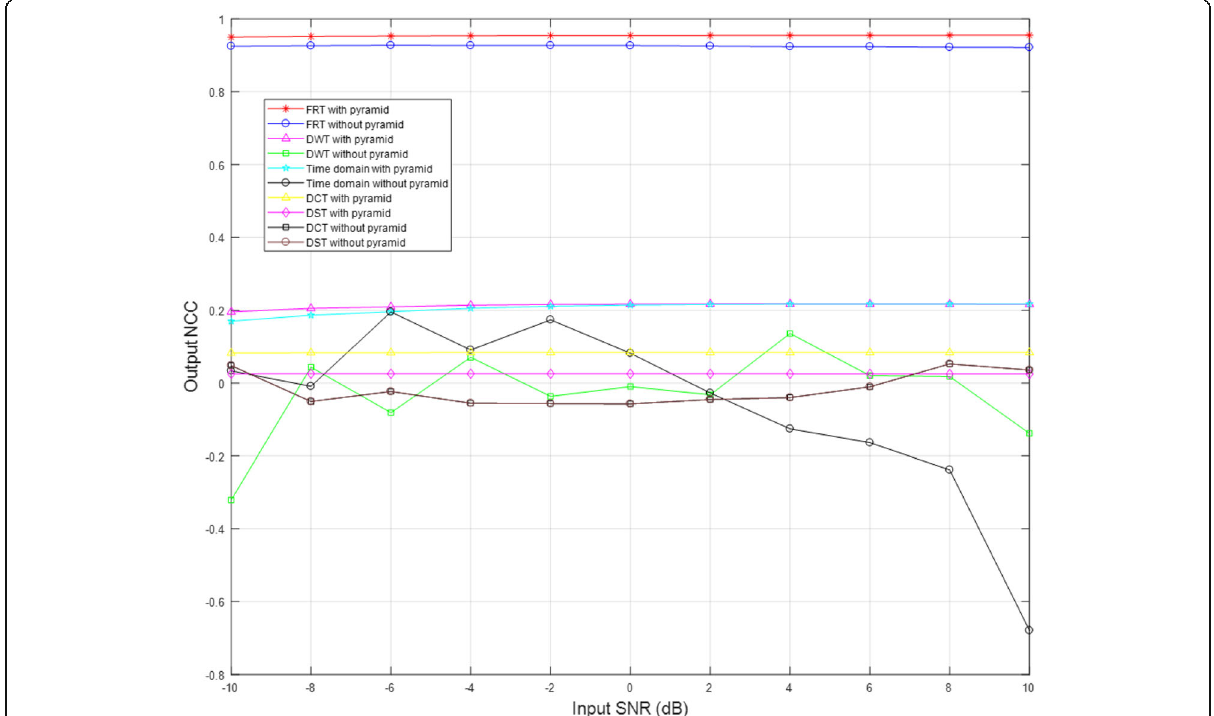
Fig. 17 Output NCC vs. input SNR for Cameraman image overall separation performances